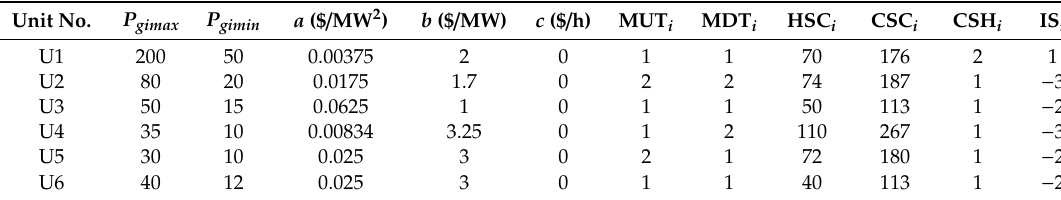
Table 2. System data for 6-unit system.